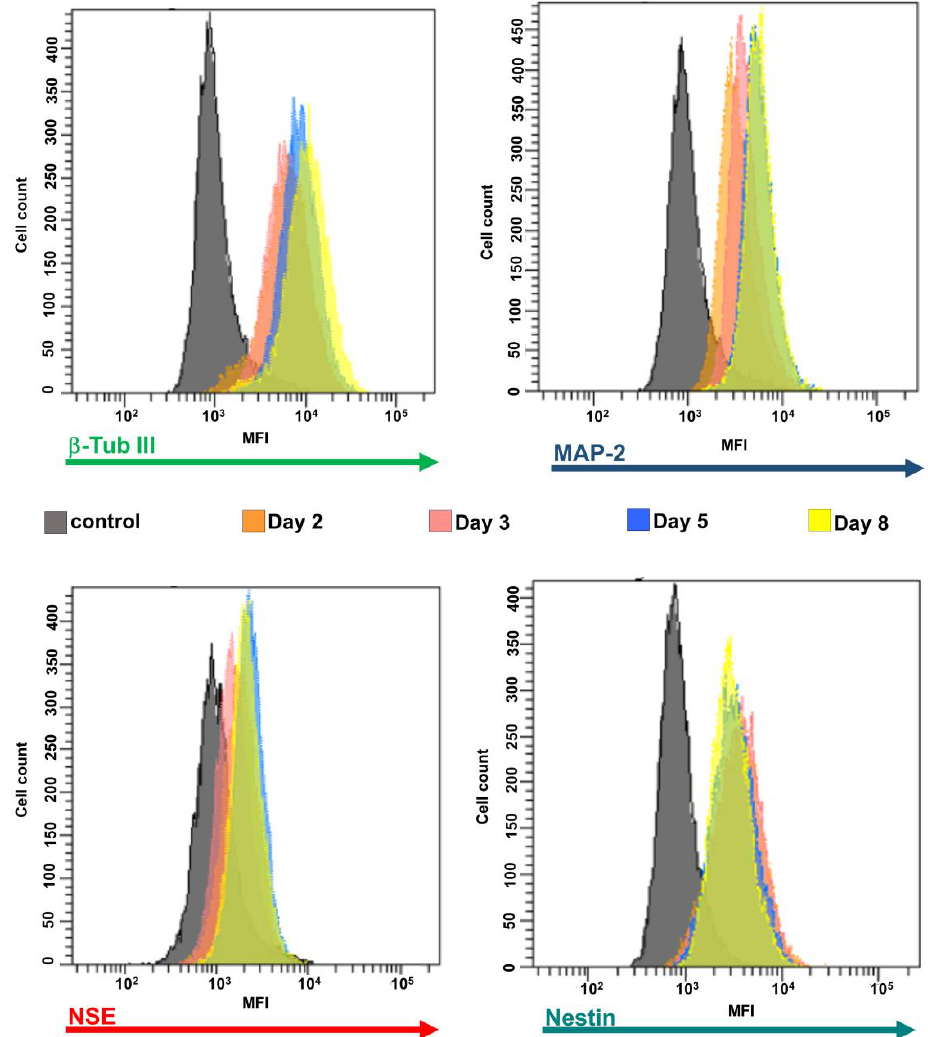
Figure 6. Expression of the neuronal markers during differentiation process. A typical flow cytometry experiment with neuronal markers and hNCLs. Control cells (without antibodies) are shown as filled gray profiles and cells incubated with alexa-fluor ® 488 or 594 labelling for β-Tub III, MAP-2, NSE, or nestin are each indicated as different color profiles at the different stages of differentiation (i.e., 2, 3, 5, and 8 days).